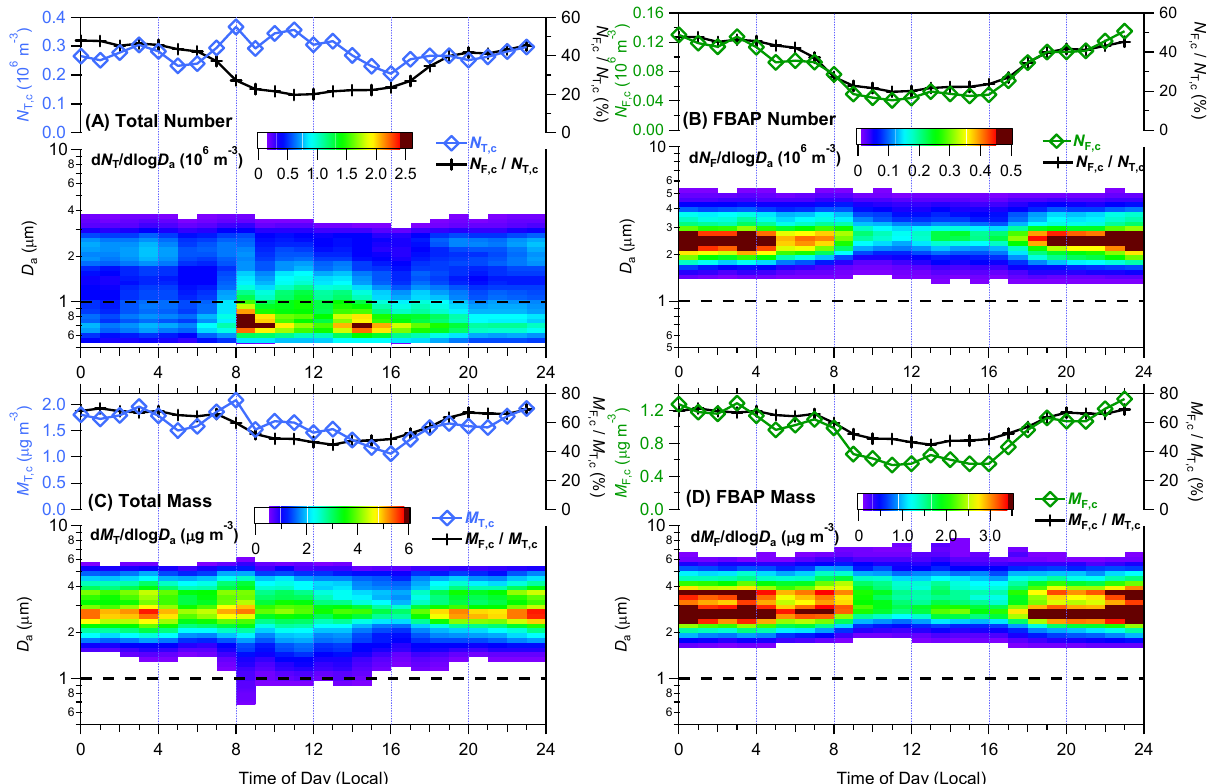
Fig. 8. Diurnal cycles of mean FBAP and total particle concentrations during low dust period (4–15 March 2008). Number and unit- normalized mass integrated 1–20µm, so peaks at small particle size not included. (A) total number, (B) FBAP number, (C) total mass, (D) FBAP mass. Black line consistent in panels of same row: (A) and (B) show relative number contribution, and (C) and (D) show relative mass contribution from fluorescent biological particles. Time of day shown as local time (LT); mass is unit-normalized. The second half of the campaign (nominally the lower dust period) was used for averaging the diurnal values to more clearly highlight the trends of